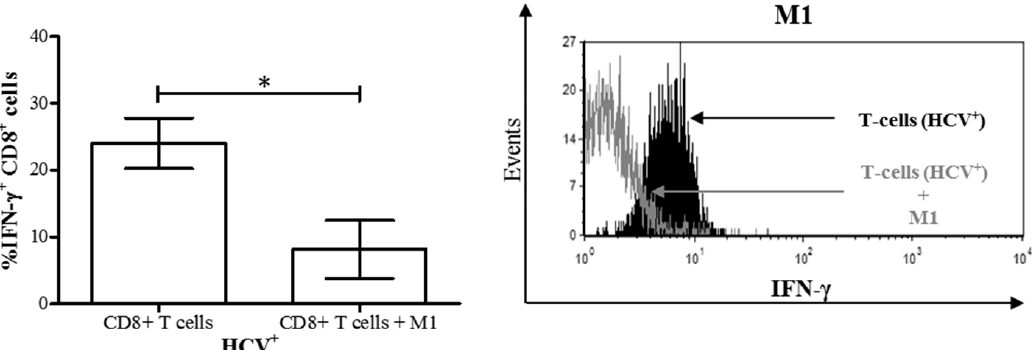
Figure 7. M1 macrophages derived from HCV-infected individuals with minimal liver fibrosis decrease the proportion of IFN- γ + CD8 + T-cells in co-culture. After differentiation from MDMs derived from blood monocytes from HCV-infected individuals, M1 macrophages were co-cultured for 24 h with autologous CD8 + T-cells isolated from frozen peripheral blood mononuclear cells. Intracellular IFN- γ expression in CD8 + T-cells was then evaluated by flow cytometry. The proportion of IFN- γ + CD8 + T-cells in co-cultures was compared to that of CD8 + T-cells cultured alone (n = 7). Representative histograms of IFN- γ expression by CD8 + T-cells co-cultured with M1 macrophages (unfilled area) superimposed over CD8 + T-cells cultured alone (black filled area) are also shown. Statistical significance was determined by a Student’s t -test ( p ≤ 0.05), and statistical significance is indicated with an asterisk “*”.